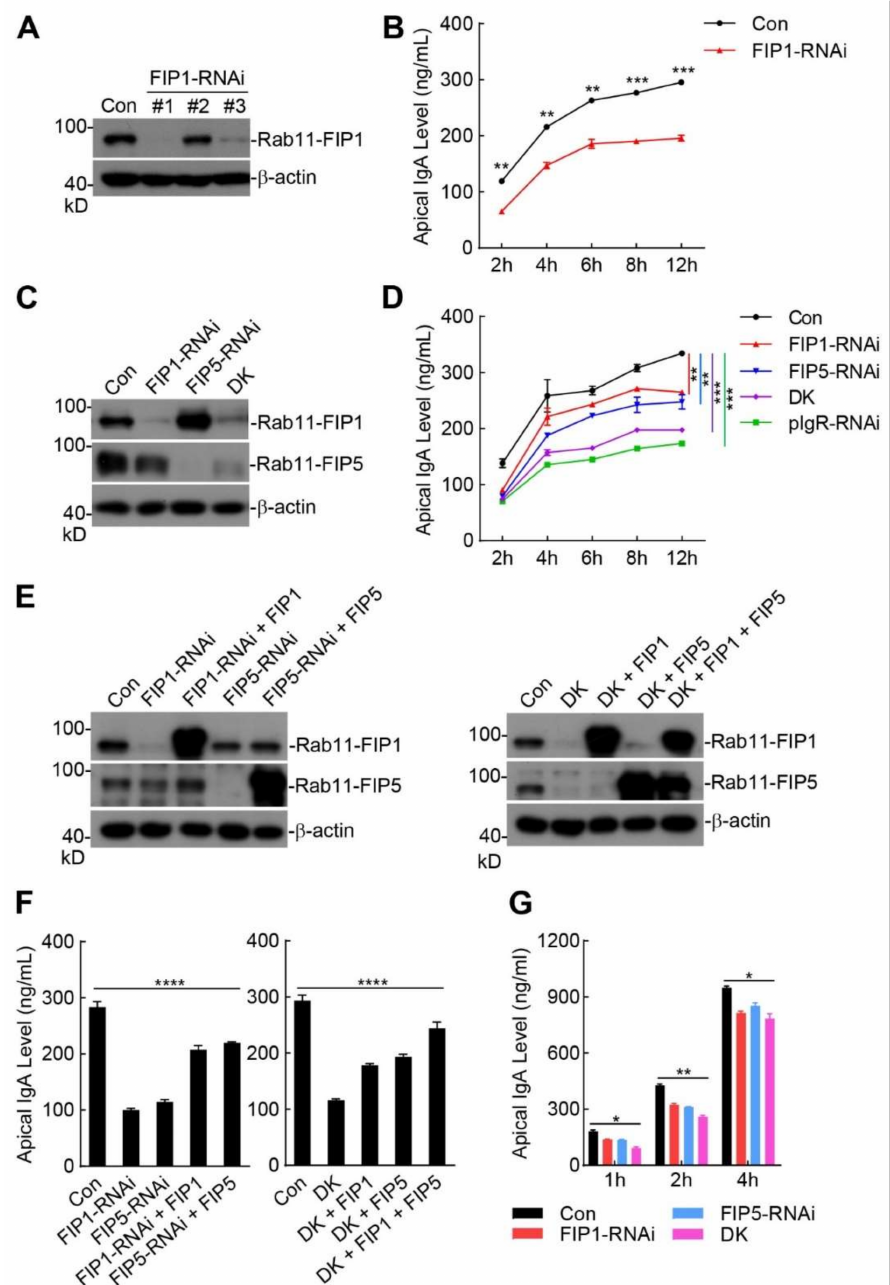
Figure 3. Knockdown of Rab11 − FIP1 or Rab11 − FIP5 impairs extracellular secretion of pIgA. ( A , B ) Ef- fects of Rab11 − FIP1 knockdown on extracellular secretion of pIgA. ( A ) Vero − pIgR cells were trans- duced with control (Con) or the indicated Rab11 − FIP1 − RNAi plasmids. The knockdown efficiencies were detected by immunoblotting analysis. ( B ) The control and Rab11 − FIP1 − RNAi Vero − pIgR cells (1 × 10 5 ) (Rab11 − FIP1 − RNAi #1 plasmid was used) were grown on Transwell for 3 days. An amount of 20 µ g pIgA was added to the basal chamber for the indicated time points. The supernatant was collected for IgA analysis by ELISA. ( C , D ) Effects of double knockdown of Rab11 − FIP1 and Rab11 − FIP5 on extracellular secretion of pIgA. ( C ) Vero − pIgR cells were transduced with the control or indicated RNAi plasmids by retroviral − mediated gene transfer to establish stable cell lines. The knockdown efficiencies of these genes in their cell lines were detected by immunoblotting analysis. ( D ) The indicated Vero − pIgR cells (1 × 10 5 ) were grown on Transwell for 3 days. An amount of 20 µ g pIgA was added to the basal chamber for the indicated time points. The supernatant was collected for IgA analysis by ELISA. DK: double knockdown. ( E , F ) Effects of reconstitution of Rab11 −